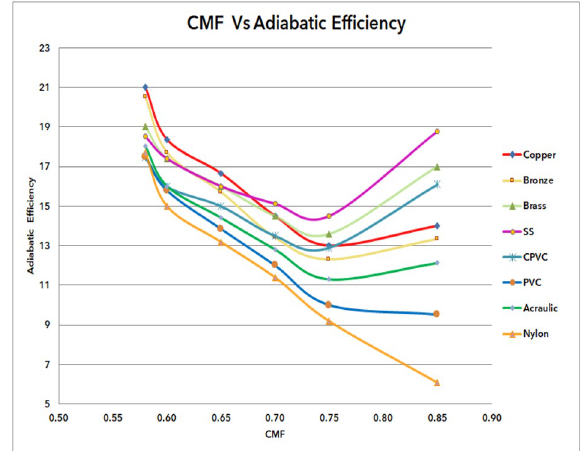
Figure 71. CMF vs adiabatic efficiency.